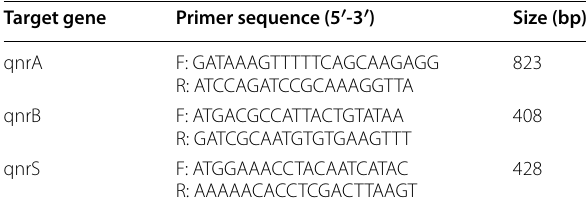
Table 1 Primers used for PCR amplification of qnr genes Target gene